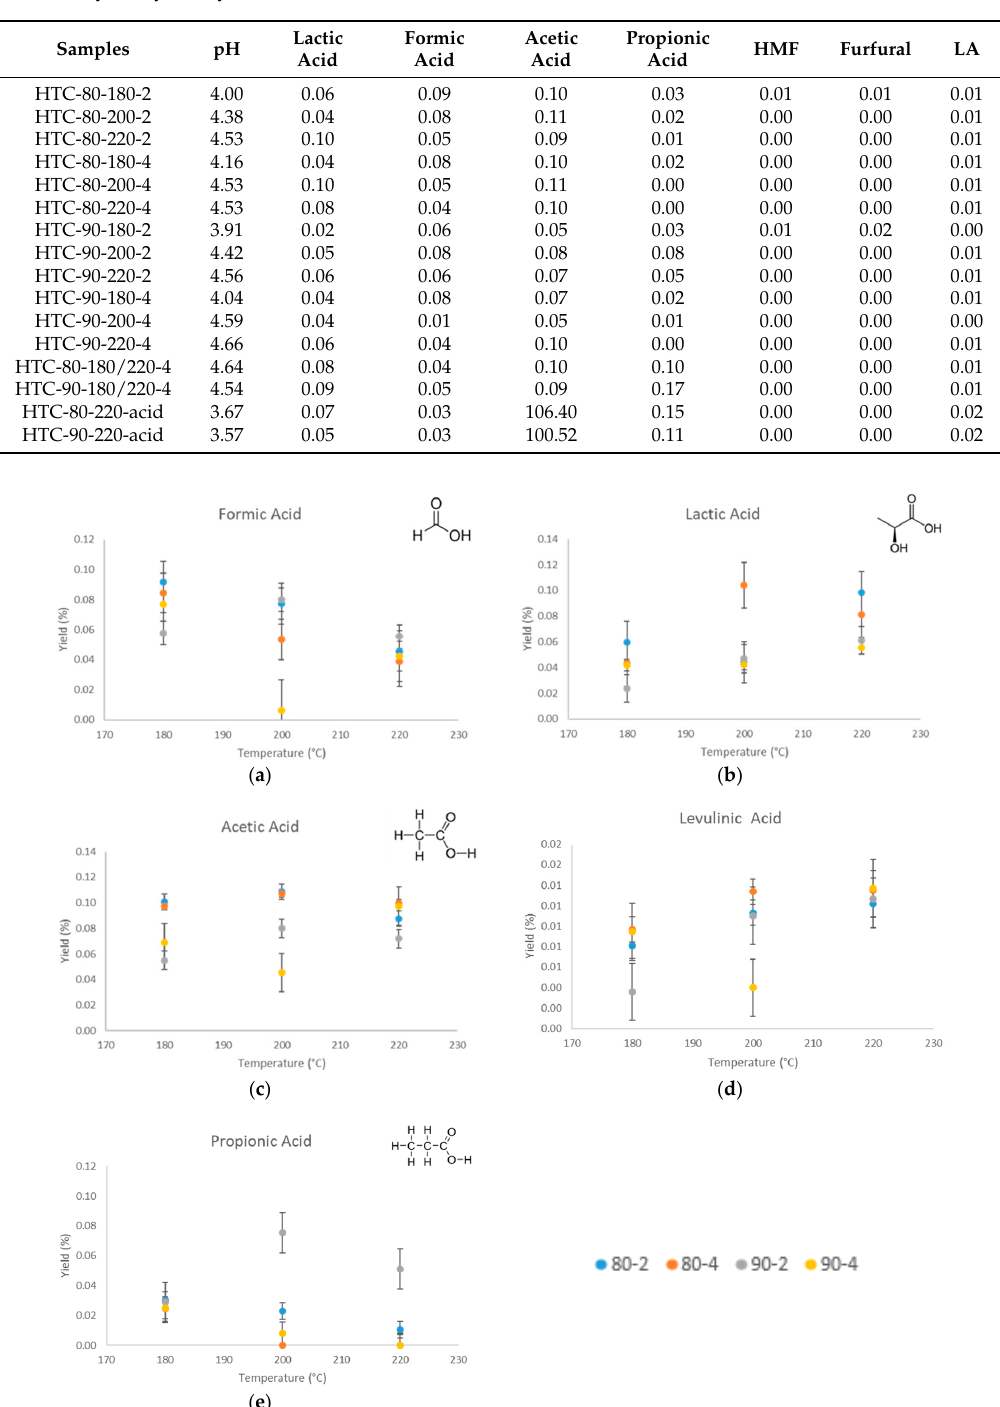
Figure 4. Yield of ( a ) formic acid, ( b ) lactic acid, ( c ) acetic acid, ( d ) LA, and ( e ) propionic acid at experimental conditions.